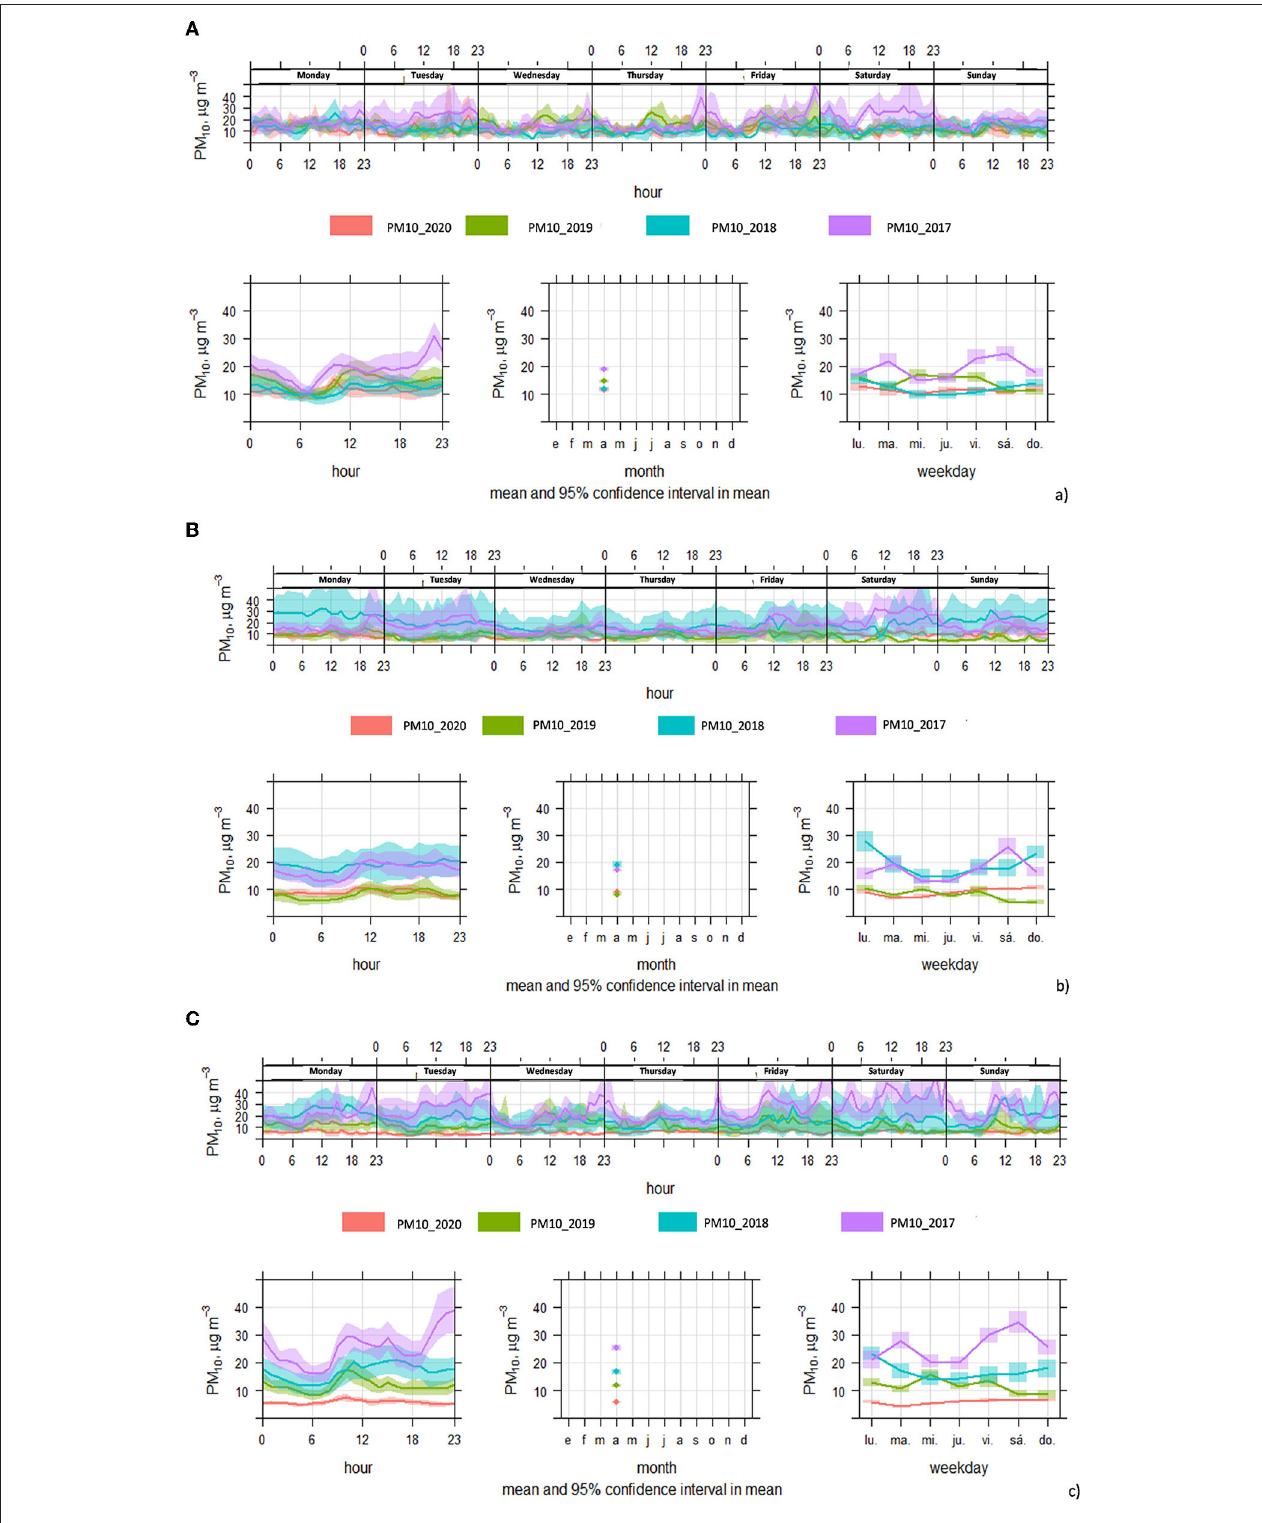
FIGURE 3 | The PM 10 time series for the consecutive months of April for three air quality station (AQS) representatives of each category: (A) Escuelas Aguirre: traffic, (B) Casa de Campo: suburban, and (C) Farolillo: background. The figure was made using the function timeVariation from the OpenAir R package (Carslaw and Ropkins,